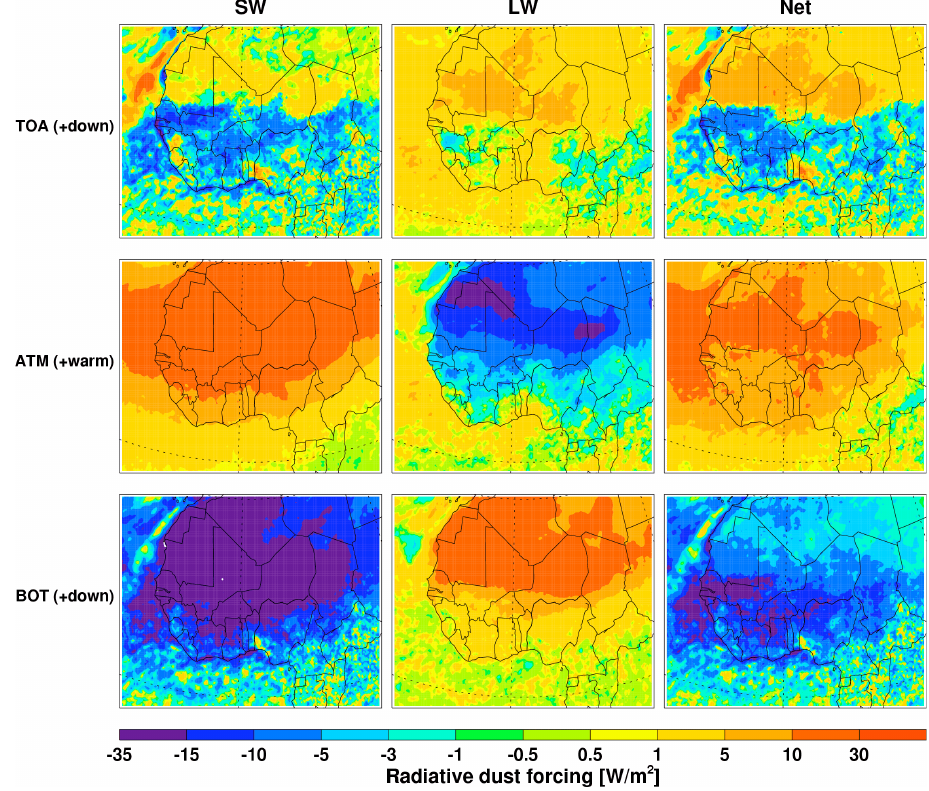
Fig. 2. Averaged all-sky SW and LW radiative forcing of dust over West Africa from WRF-Chem simulations. “TOA (+down)” represents the dust radiative forcing at the top of atmosphere and positive refers to downward direction; “ATM (+warm)” represents the dust radiative forcing in the atmosphere and positive refers to warming effect; “BOT (+down)” represents the dust radiative forcing at the surface and positive refers to downward direction. “Net” represents the sum of dust SW and LW radiative forcing.